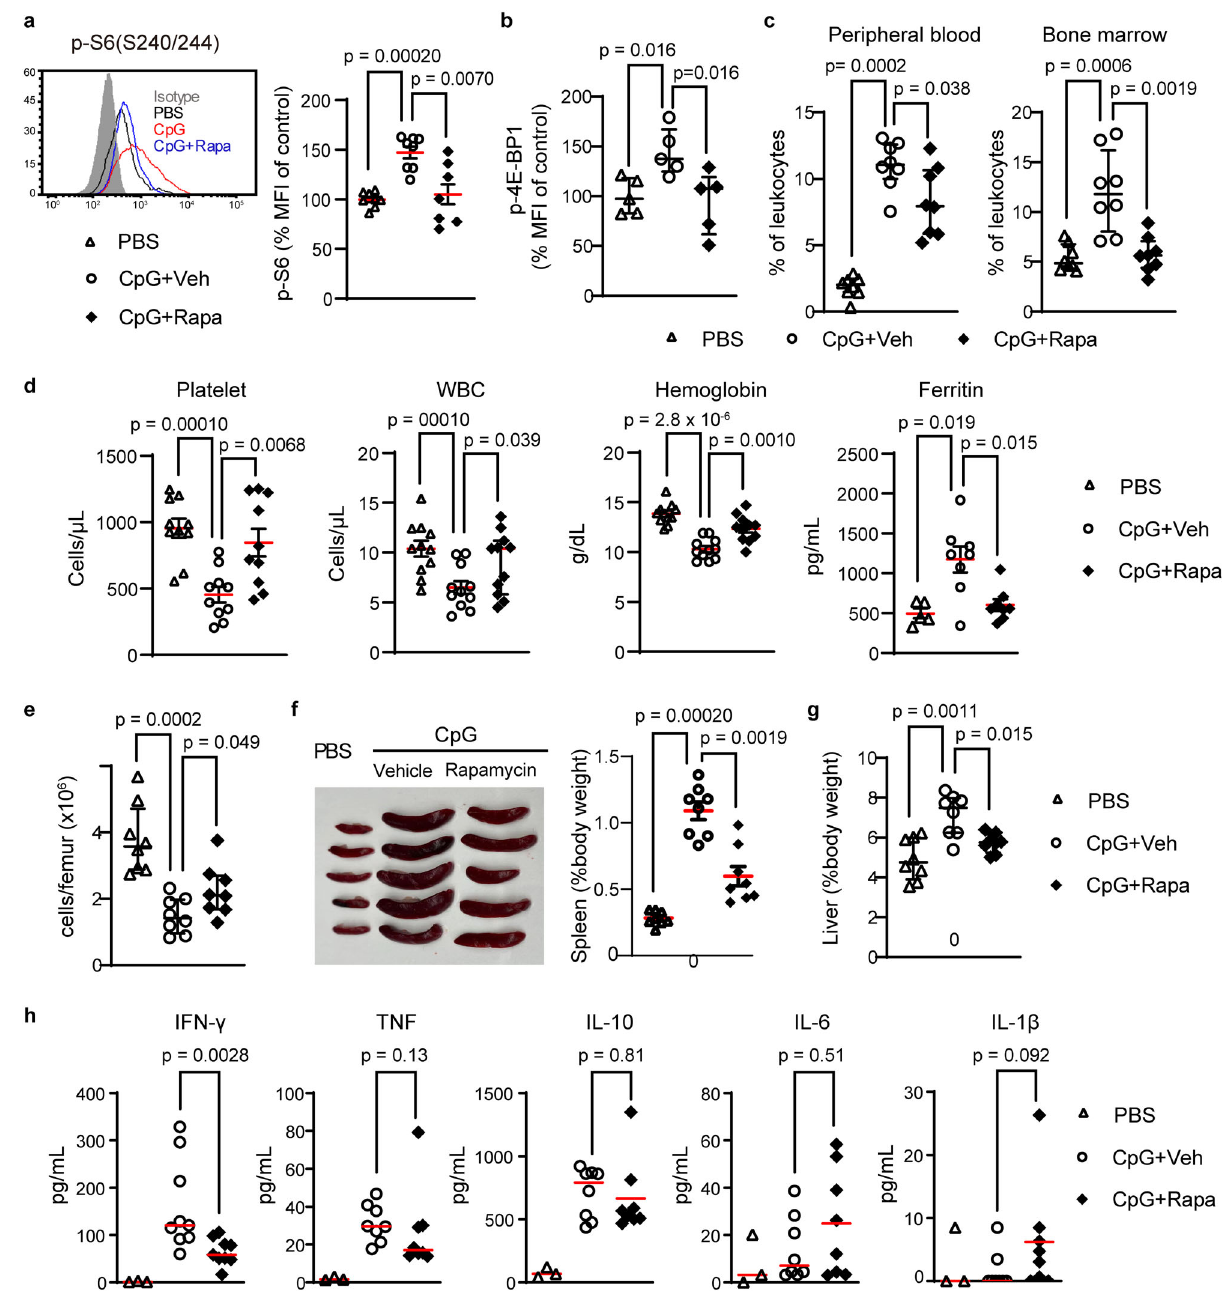
Fig. 6 | mTORC1 activation drives CpG-induced macrophage activation syn- drome. a Phospho-S6 staining ( n =8 per group) and ( b ) phospho-4EBP1 staining ( n =5 per group) in bone marrow Ly6C hi monocytes, ( c ) fl ow cytometry quanti fi - cation of peripheral blood and bone marrow Ly6C hi monocytes ( n =8 per group), ( d ) hematologic parameters ( n =11 per group) and ferritin levels (PBS, n =5; CpG+ Vehicle, n =8; CpG+ Rapamycin, n =8), ( e ) absolute bone marrowcellcount ( n =8 per group),( f ) representative depiction and quanti fi cation ofspleen size ( n =8 per group), ( g ) liver size ( n =8 per group), and ( h ) plasma cytokine levels (PBS, n =3;